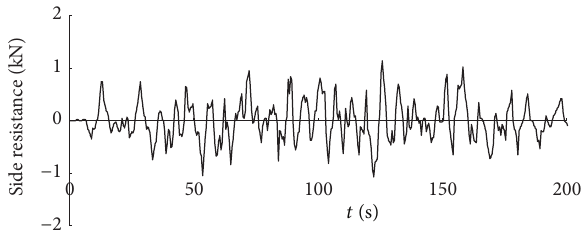
Figure 7: Time history curve of side resistance on cutting pick.